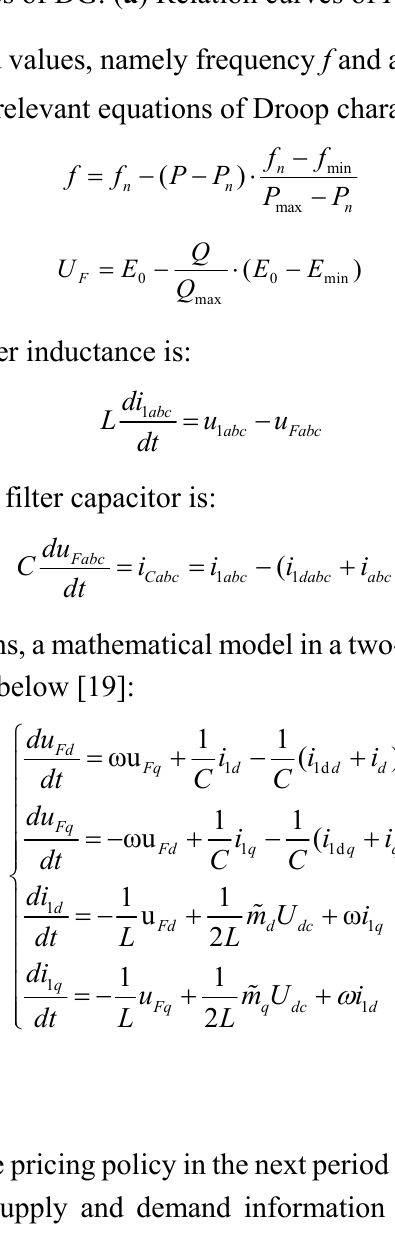
Figure 4. Droop characteristics of DG: ( a ) Relation curves of P – f ; ( b ) Relation curves of Q – U